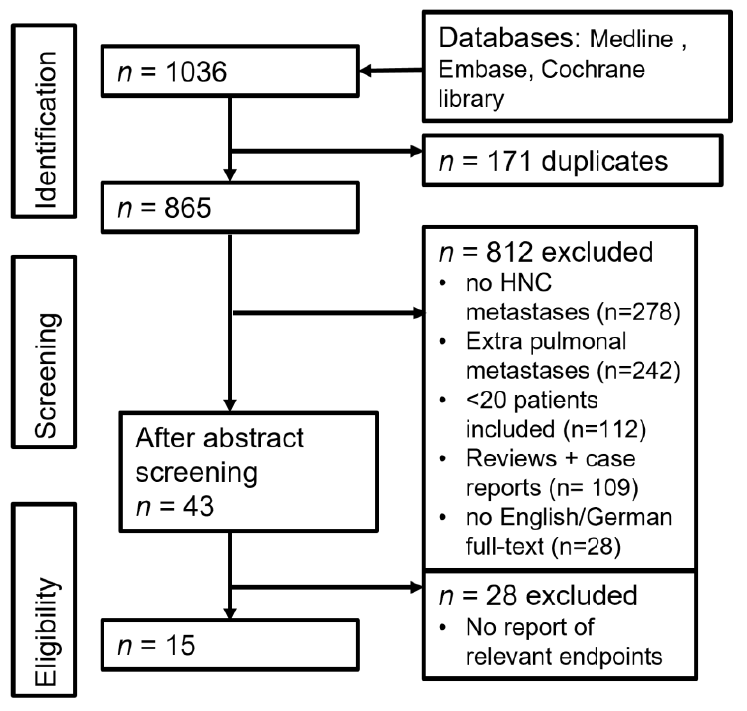
Figure 1. Flow-chart of literature research.